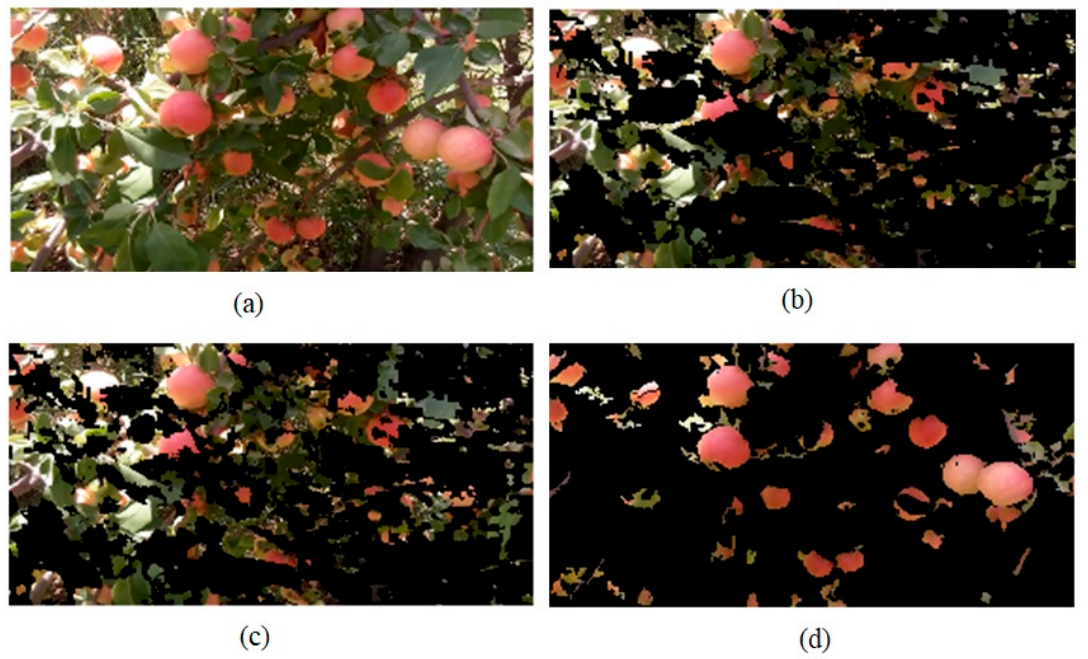
Figure 5. The performance of segmentation algorithm in different modes of ordering color, texture, intensity transformation methods. ( a ) Original image. ( b ) The resulting image after applying the sequence of the texture method, the color method and the intensity transformation method. ( c ) The resulting image after applying the sequence of the intensity transformation method, the texture method, the color method. ( d ) The image obtained after applying the sequence of the color method, the texture method, the intensity transformation method.